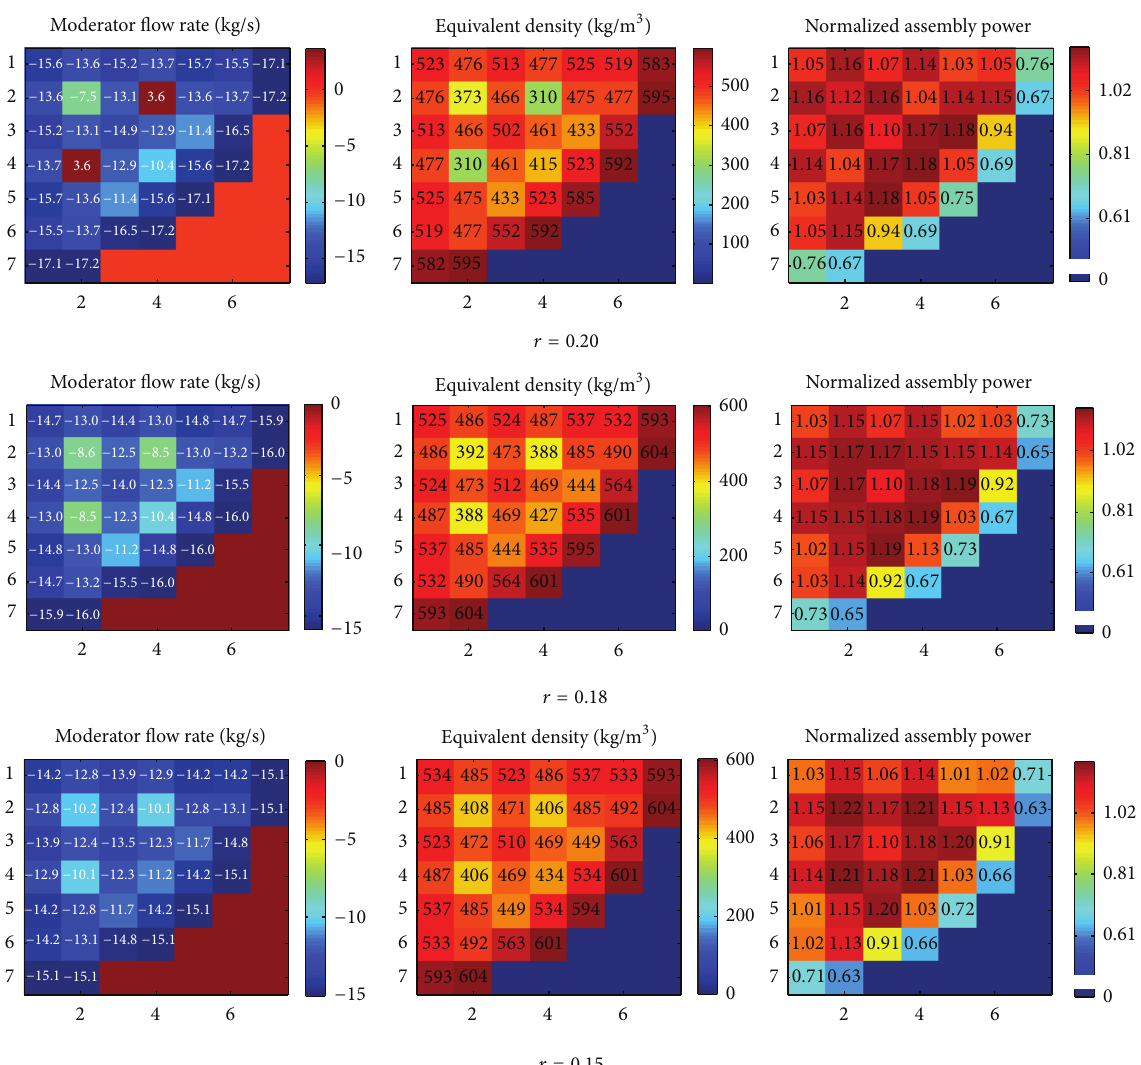
Figure 3: Moderator flow rate, equivalent density, and normalized assembly power (reference value 24.59 MW) in different orifice area ratio /𝐴 𝑟 = 𝐴 𝑜 mod